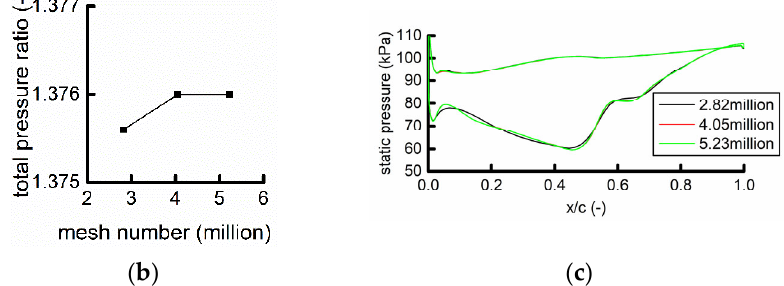
Figure 12. Mesh convergence verification (different mesh numbers). ( a ) Efficiency ( b ) Total pressure ratio ( c ) Steady static pressure at 50% blade span.